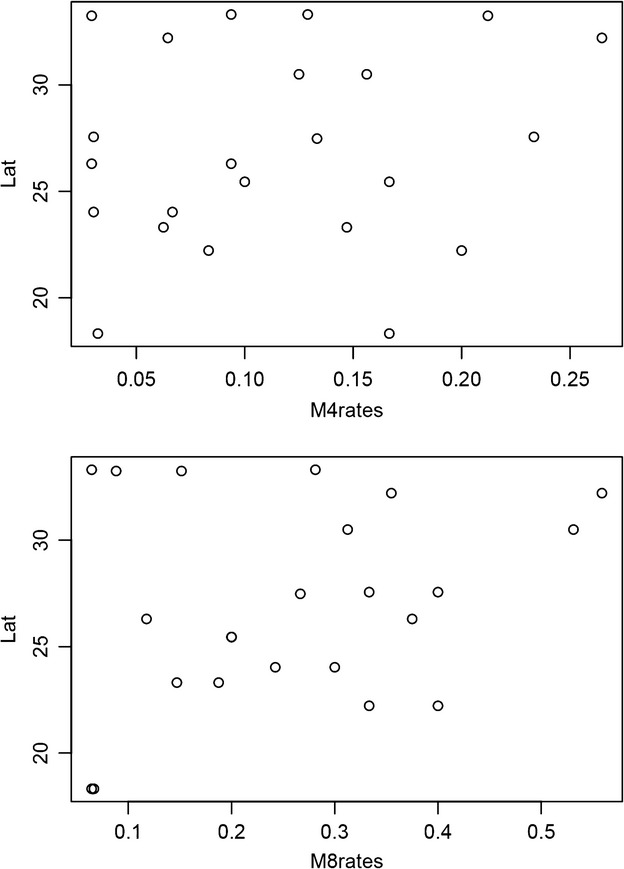
Short-term (top) and long-term (bottom) remating rates of females plotted against latitude.